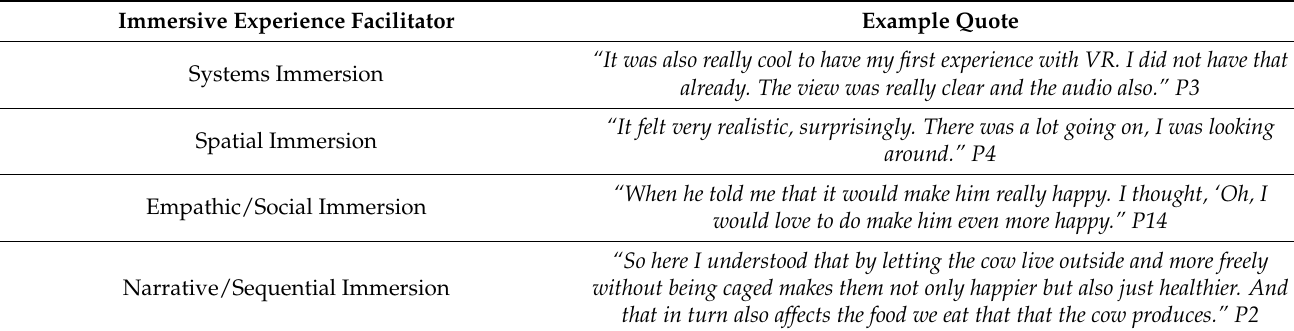
Table 4. Quotes per immersive experience